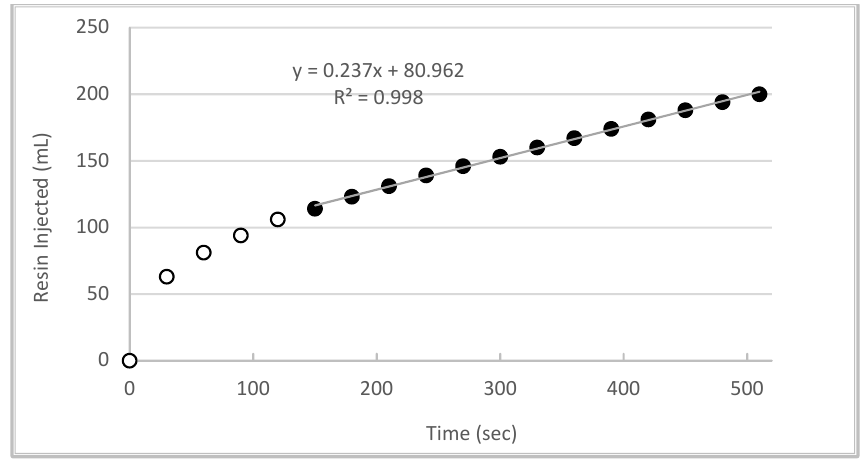
Figure 4. Experimentally measured representative volumetric flow rate during RTM.